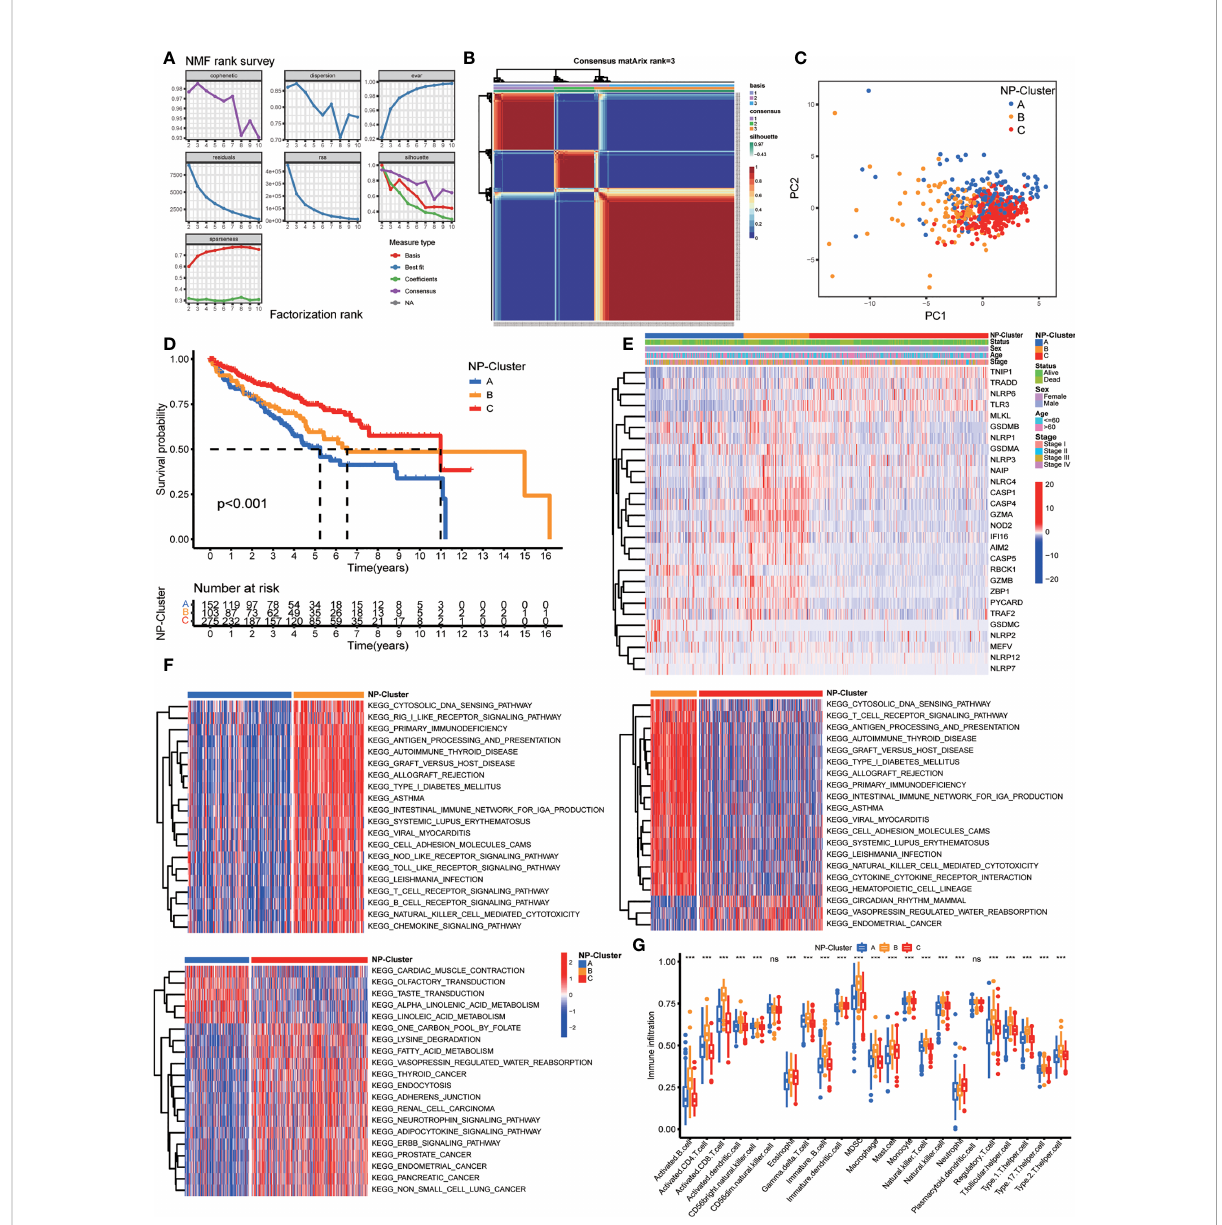
FIGURE 2 Risk classi fi cations and related functional annotation based on the DE-NPRGs. (A, B) Consensus clustering matrix in ccRCC patients with best cluster number of three (k = 3). (C) ccRCC patients in TCGA cohort were strati fi ed into three groups. (D) Kaplan-Meier curves for the three clusters. (E) Heatmap showing the clinicopathologic characteristics formed by DE-NPRGs and clinical features in three NP-clusters. (F) Heatmap of GSVA enrichment scores comparisons for the differentially expressed pathways in three NP-clusters. (G) Comparison of ssGSEA scores for immune in fi ltration of ccRCC in three NP-clusters and results visualization. *** P< 0.001; ns, no signi fi